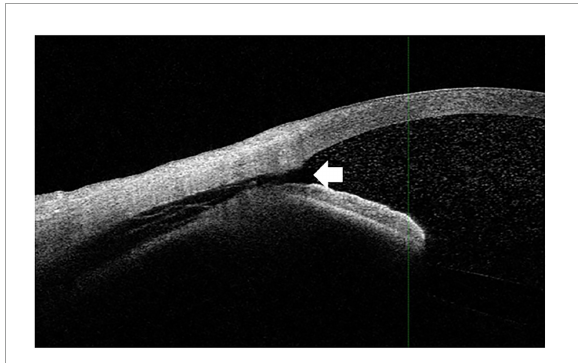
FIGURE4 The connection between the anterior chamber and CCD. The white arrowhead indicates that the CCD was connected to the anterior chamber. The imaging shown in this figure was performed in the nasal quadrant.